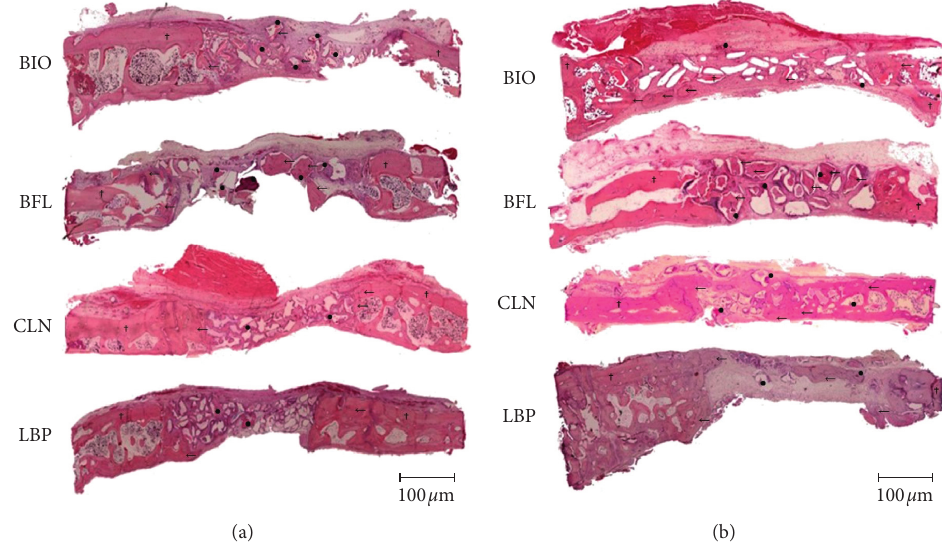
Figure 1: Histological panoramic images of bone defects filling biomaterials (BIO, BFL, CLN, and LBP), in the experimental periods of 14 and 40 days postoperatively (HE staining, original magnification 63x). Lamellar bone (†), newly formed bone ( ← ), and remaining biomaterial ( ● ). (a) 40 days. (b) 14